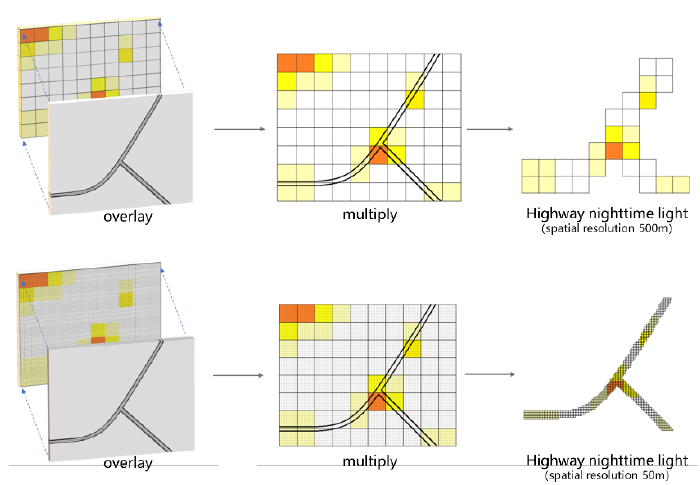
Figure 5. Schematic diagram of highway pixel density.